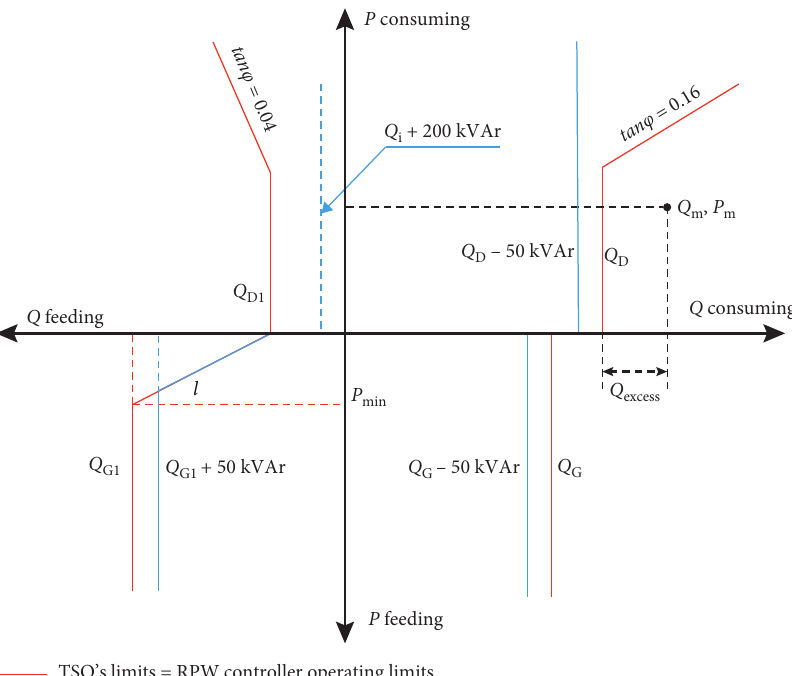
Figure 5: The setup for the controller